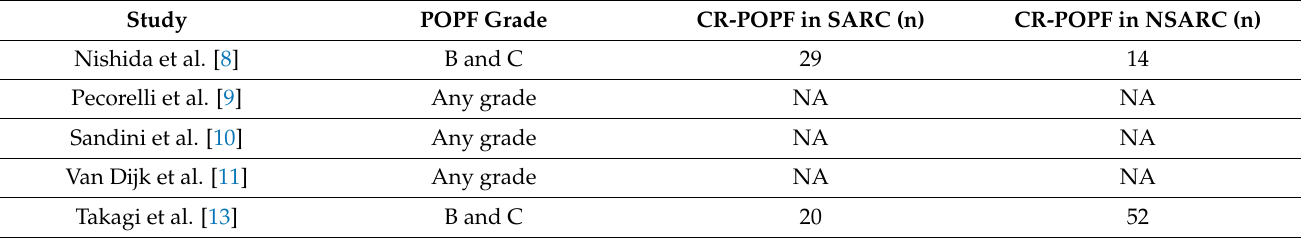
Table 6. POPF severity (ISGPF classification) in patients undergoing